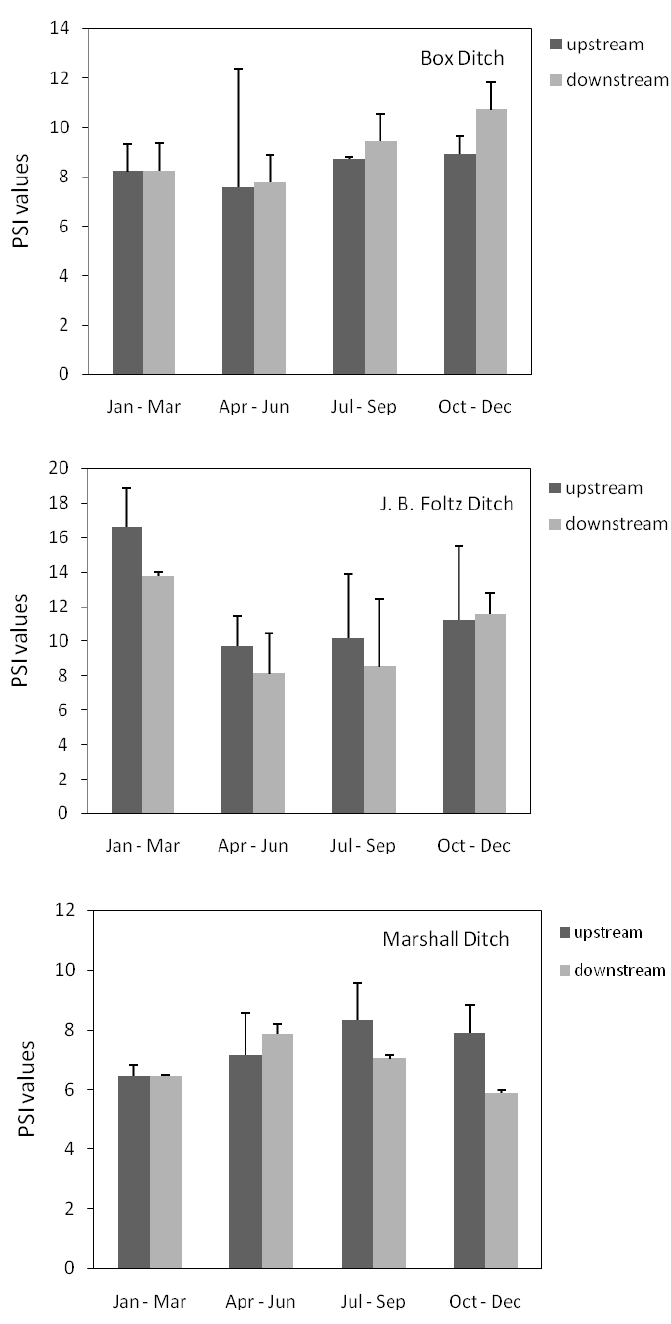
Figure 3. Ability for P uptake of upstream and downstream sediments from tile drains in the three